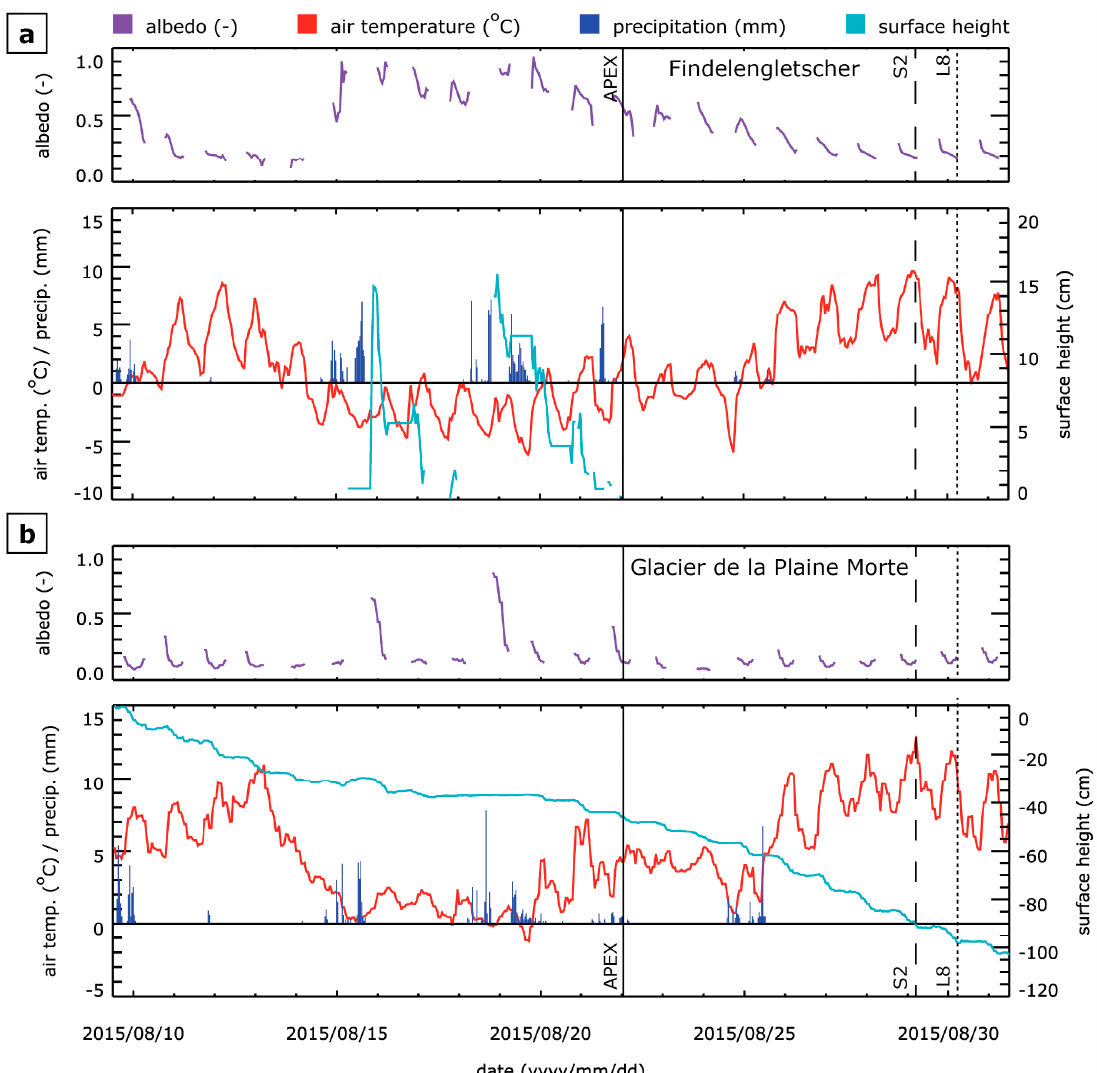
Figure 2. Albedo, temperature and precipitation for ( a ) Findelengletscher and ( b ) Glacier de la Plaine Morte. Airborne/satellite acquisitions: APEX (solid line), Sentinel-2 (dashed line) and Landsat 8 (dotted line). Surface height data for Glacier de la Plaine Morte is plotted with respect to 10 August, i.e., surface height is set to 0 cm for that date.